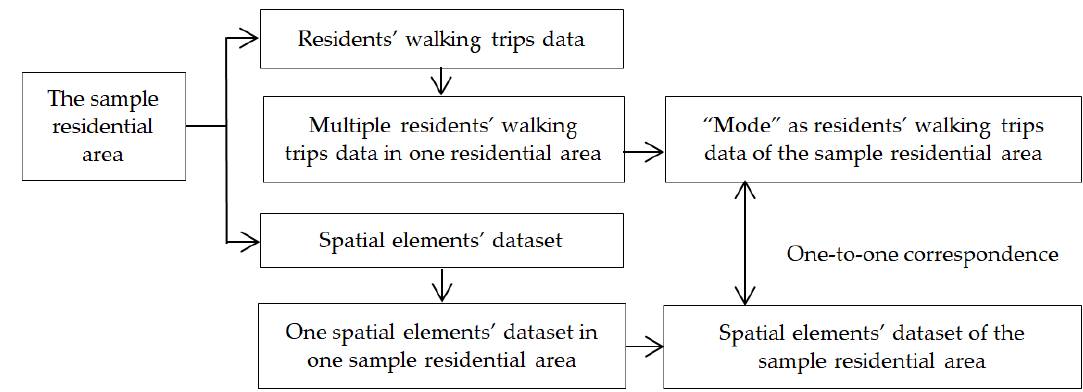
Figure 2. One-to-one data correspondence.